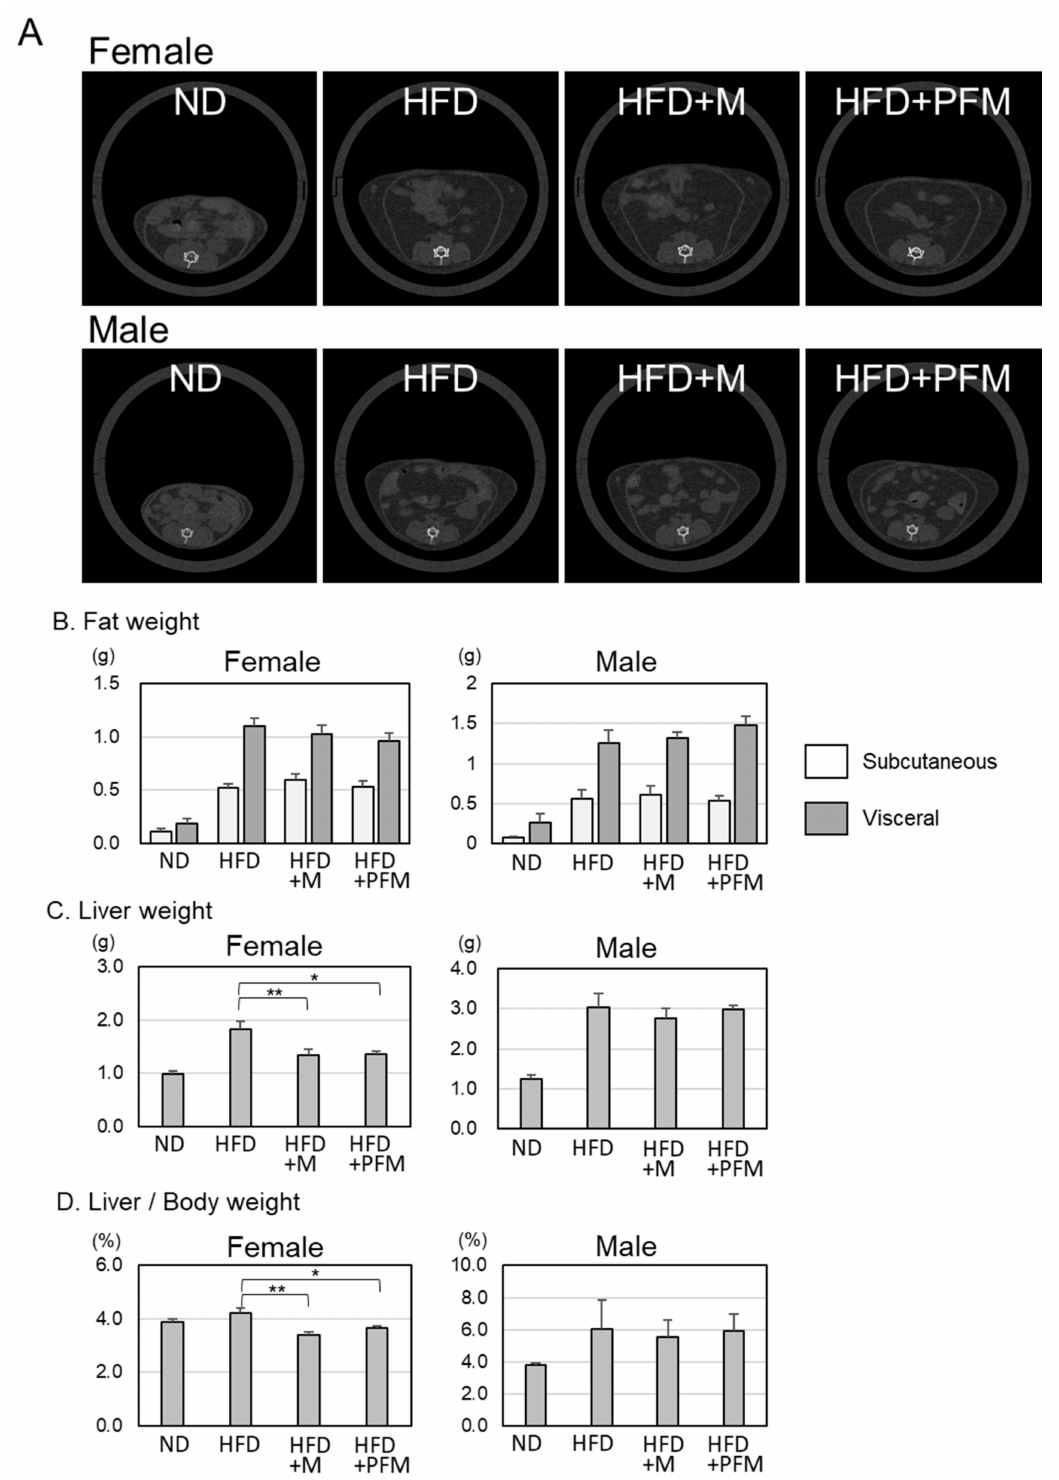
Figure 2. The reduction in visceral fatty tissue and liver weight in female mice by the consumption of miso or PFM. ( A ) Representative CT abdominal images of male and female mice used for quantification of abdominal fat deposits. ( B ) The area of adipose tissue was measured and converted to weight with Latheta software. White and gray bars indicate subcutaneous and visceral adipose tissue weight, respectively. ( C , D ) The liver weight ( C ) and liver/body weight ( D ) of mice. Error bars indicate SEM ( n = 5 or 6). Values with different superscripts are significantly different among HFD groups by ANOVA with Tukey’s multiple comparison test. * p < 0.05; ** p <